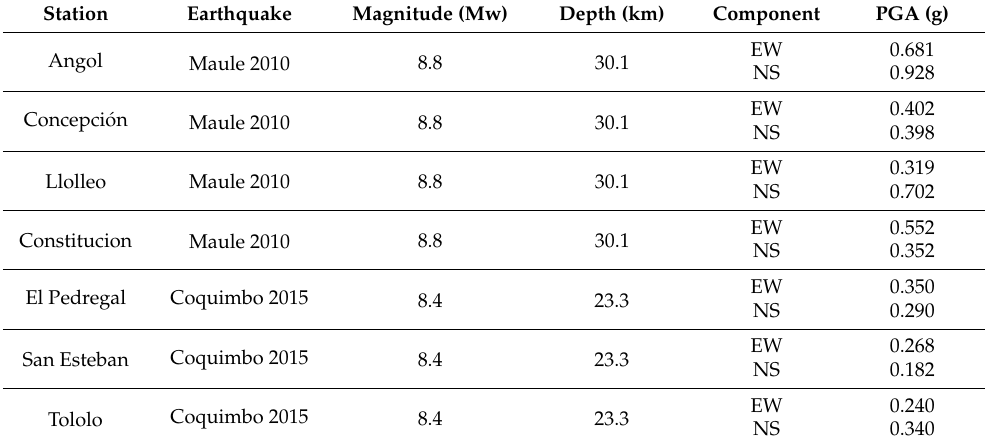
Table 2. Ground motion suite